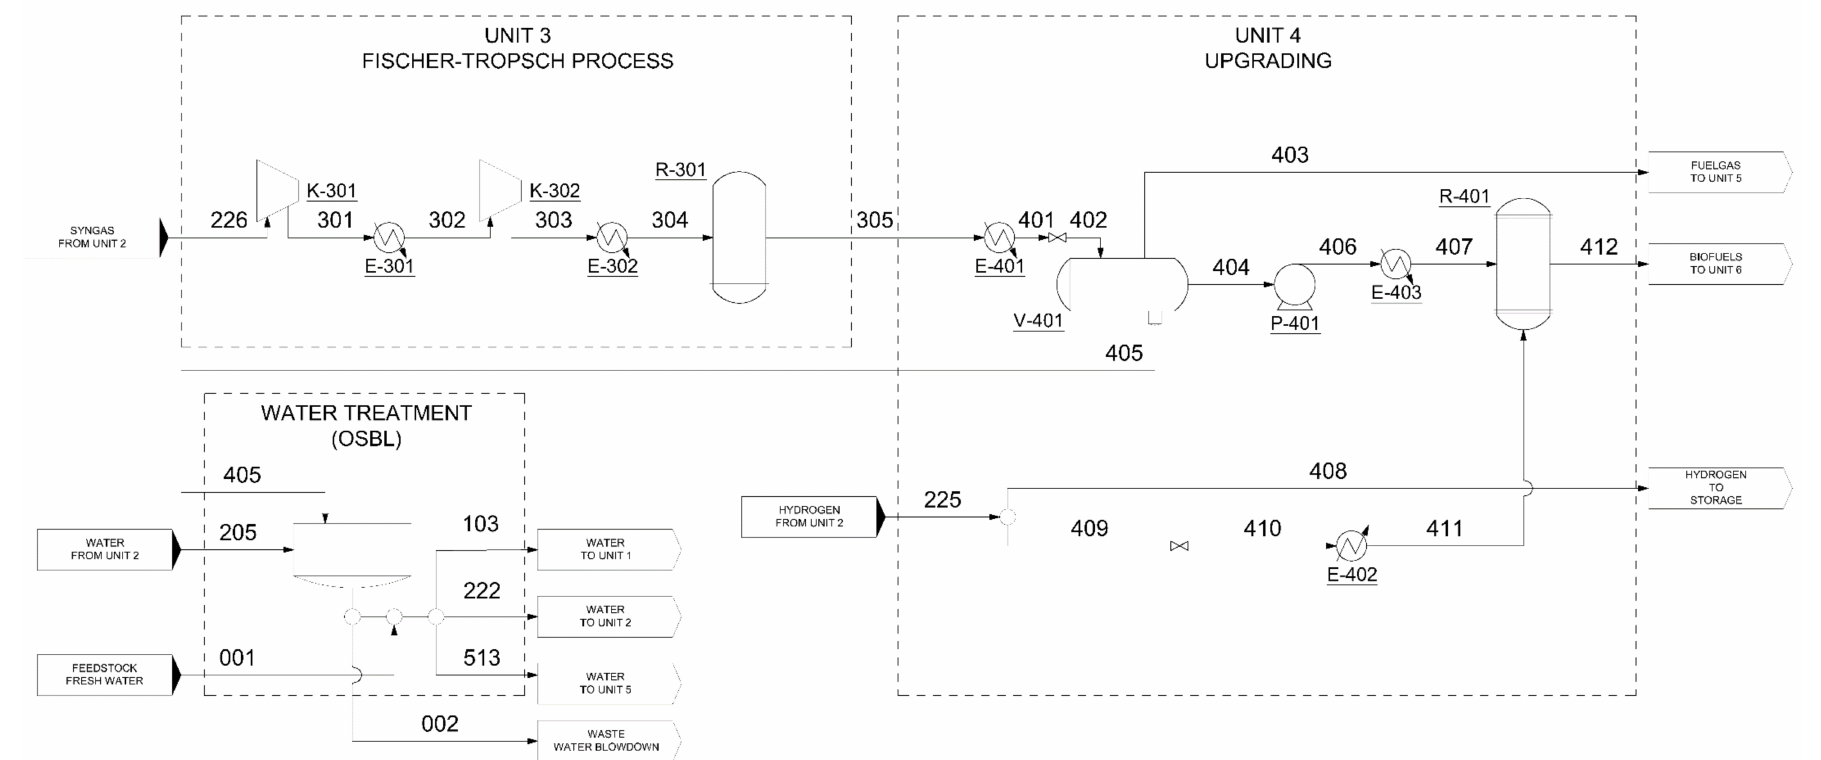
Figure 2. Fischer-Tropsch and upgrading (units 3 and